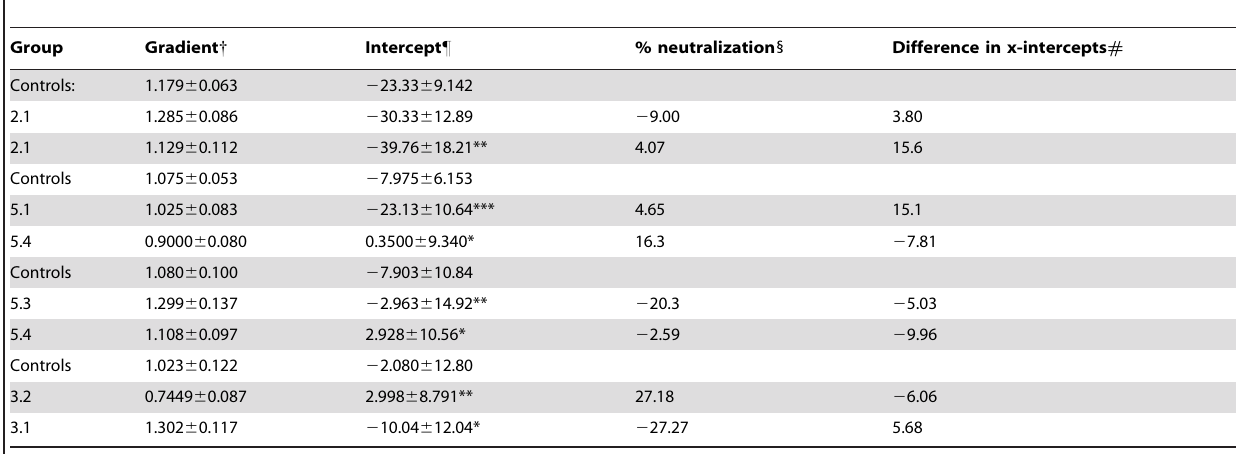
{ Number of fluorescent cells/dose of infectious virus. " Number of fluorescent cells (point where plot crosses vertical axis). 1 Gradient of plot with serum from immunized macaque divided by gradient of plot with control serum expressed as a percentage. # Dose of infectious virus (interval between points where plots for sera from immunized and control macaques cross horizontal axis). Significant difference with controls: ***p , 0.001; **p , 0.01; *p ,